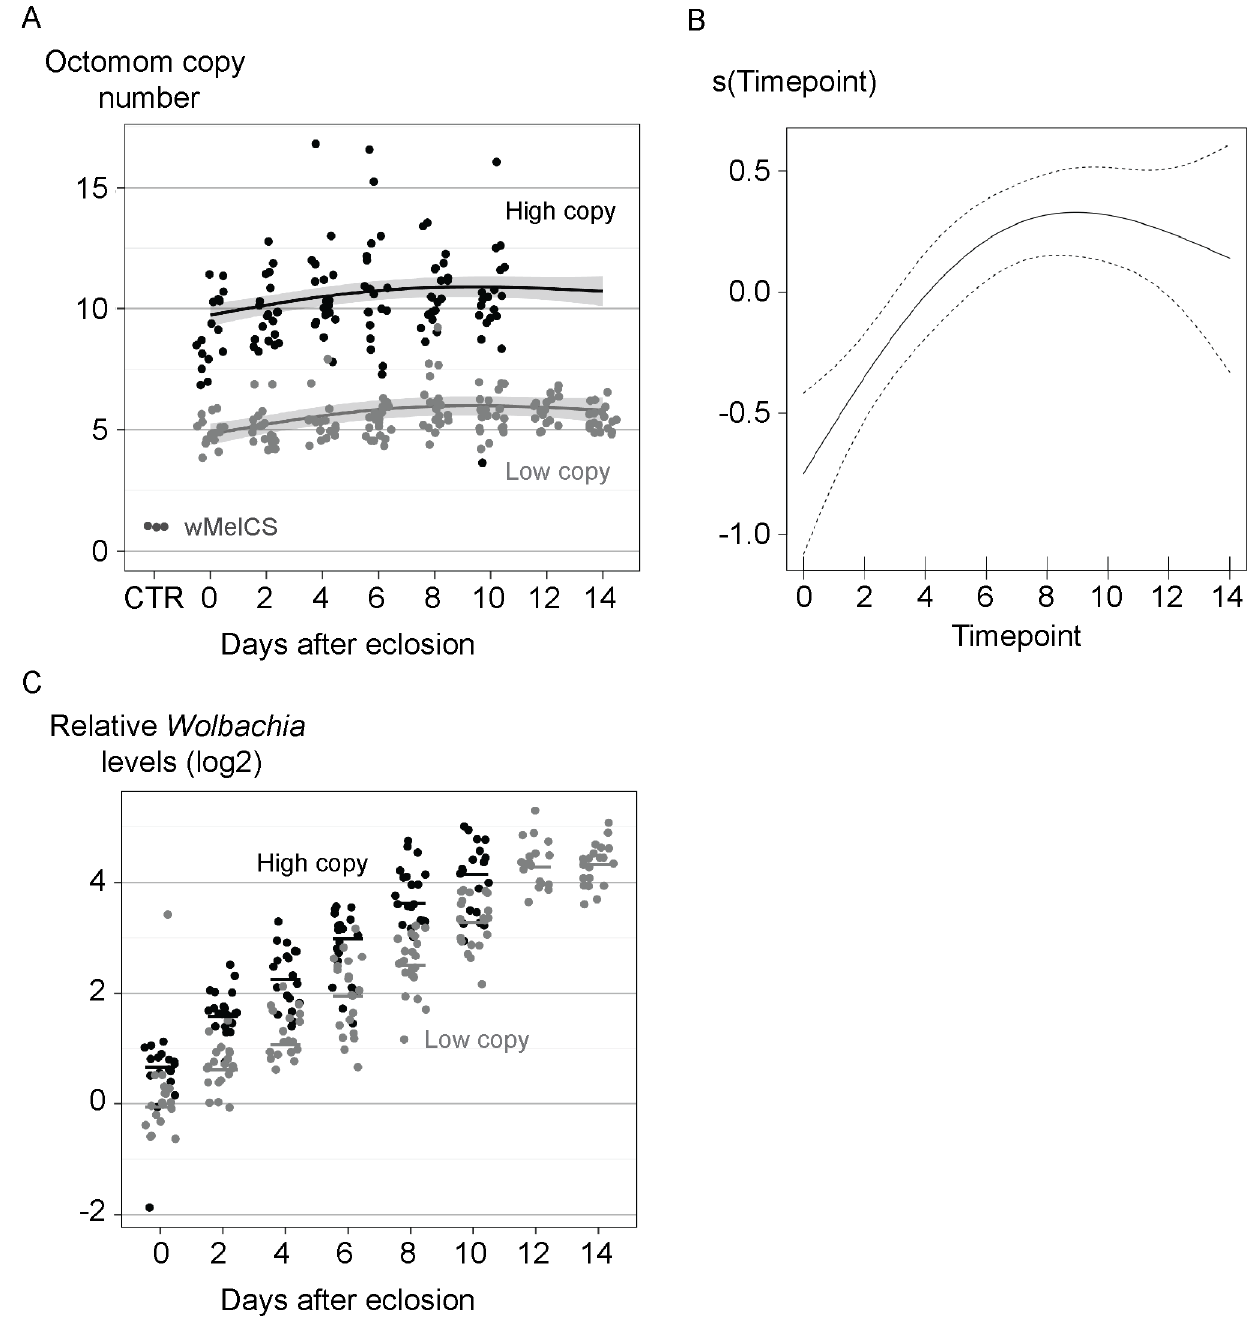
Fig 1. Octomom copy number and Wolbachia levels during adult D . melanogaster life. (A) Each dot represents WD0513 genomic levels in a single fly, as we have previously shown that this gene can be used to estimate Octomom region copy number [5]. The values were obtained using the Pfaffl method with wsp as a reference gene and calibrated using the median of three samples of control w MelCS_b flies (CTR). The lines represent the fit of the generalized additive model (GAM) and shaded area—the 95% confidence interval. (B) Fitted GAM smooth of Octomom copy number in response to the age of adults. The 95% confidence interval is indicated by the dashed lines. Note the Y-axis is standardized so that average is zero. (C) Each dot represents wsp levels in a single fly. Lines are medians of the replicates. wsp levels were obtained using Pfaffl method with Rpl32 as a reference gene and calibrated using the median of the low copy number samples at time zero. (A) and (C) represent data from single females derived from the 3 rd generation of selection for Octomom copy number in the DrosDel isogenic w 1118 genetic background [5]. Females were raised and kept at 25˚C (survival of their siblings is shown in Fig S5A of [5]). Supporting data can be found in S1 Data.